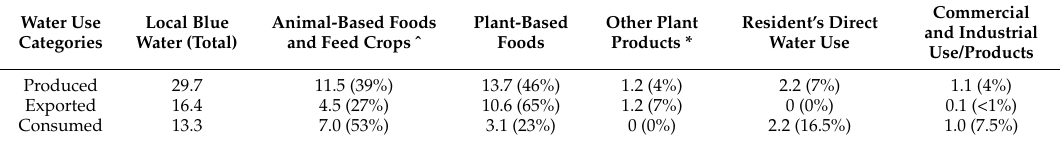
Table 2. Volume of local blue water (BCM per year) produced, exported and consumed by various California sectors. The volume of blue water devoted to each of these sectors for the three water use categories is shown in parentheses. Based on data presented by the Pacific Institute